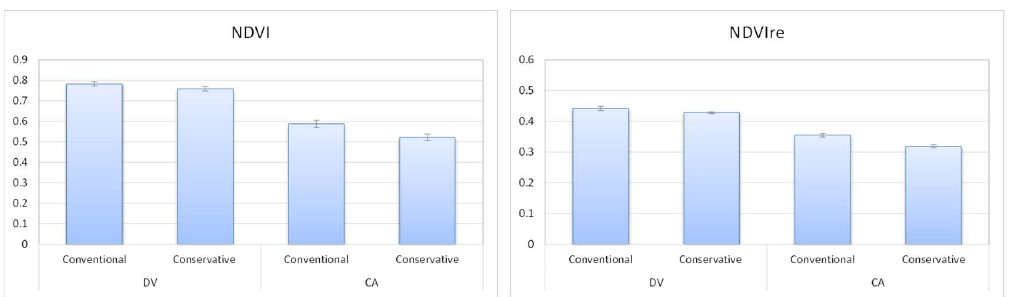
Figure 12. Elevation profiles of the CA site, obtained by orthogonally sectioning the overall area.